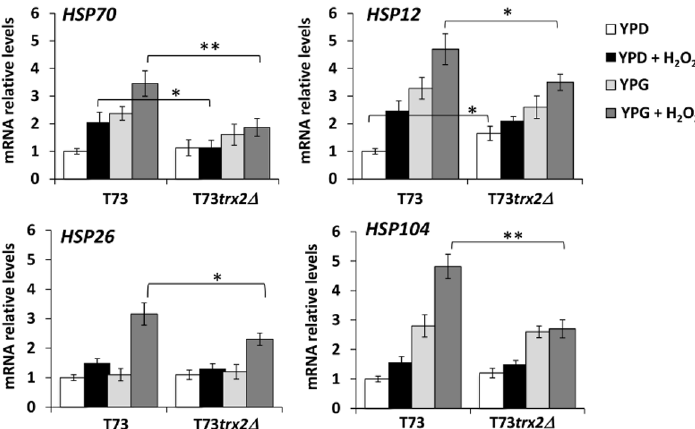
Figure 4. The expression analysis of the heat shock protein genes after exposure to oxidative stress conditions. (A) Northern blot analysis of HSP12, HSP26, HSP70 and HSP104 in strains T73 and T73 trx2∆ grown on YPD or YPG to the mid-log phase and treated with 5 mM H O for 60 min. (B) Relative expression levels were quantified by an image analysis. The data for 2 2 each gene were normalized to the expression levels of the control strain in YPD medium under non stressed conditions. Three independent experiments were carried and the error bars corresponding to SD are shown. Statistical analyses were performed using a Student´s t-test between samples in the same growth media, YPD or YPG (* p< 0.05, ** p<